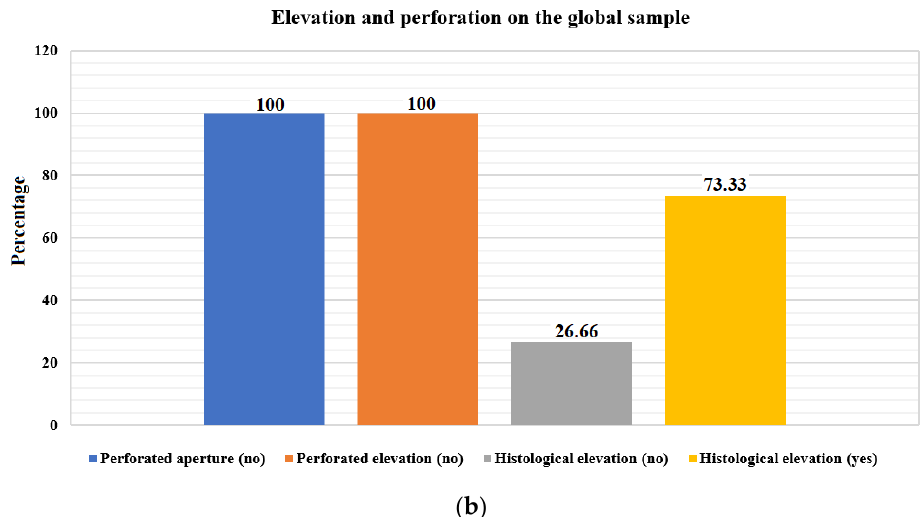
Figure 3. ( a ) Distribution of the histological elevation and the membrane perforated in the height groups, ( b ) Distribution of the histological elevation and the membrane perforated on the global sample.